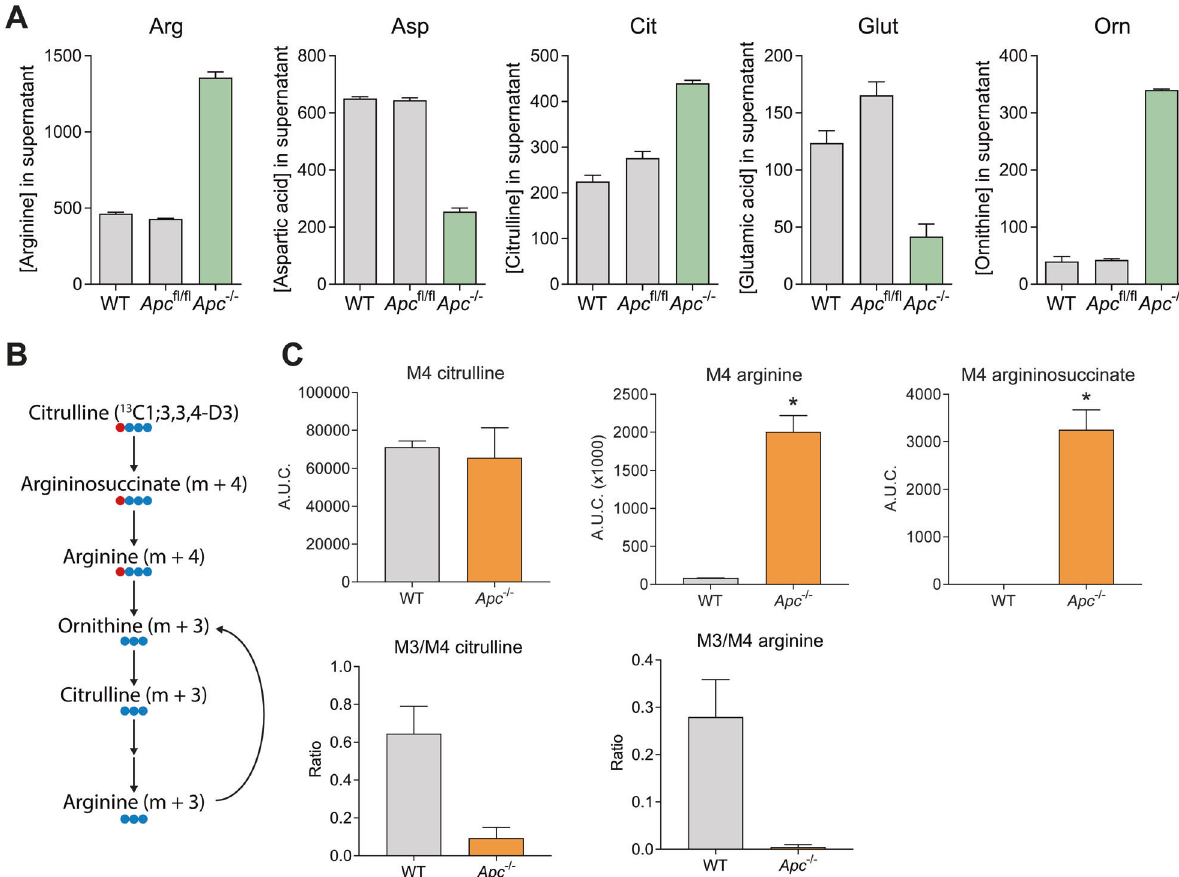
Fig. 3 Loss of Apc leads to altered amino acid consumption and synthesis. A Amino acid concentrations as measured by HPLC in supernatant of wild-type, VillinCre ERT2 Apc fl / fl , and VillinCre ERT2 Apc − / − organoids. B schematic overview of labeling. C LC-MS measurement of intracellular M4 citrulline, M4 arginine, and M4 argininosuccinate, in wild-type and VillinCre ERT2 Apc − / − organoids after incubation with labeled M4 citrulline (13C1;3,3,4-D3), and ratios between M3/M4-labeled citrulline and arginine. * p < 0.05 by student ’ s t